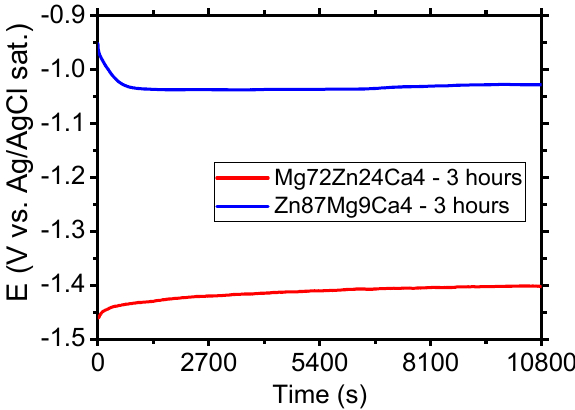
Figure 6. Evolution of open circuit potential (OCP) for Mg 72 Zn 24 Ca 4 and Zn 87 Mg 9 Ca 4 alloys specimens in Ringer’s solution at 37 ° C; pH 7.2 after 3 h.